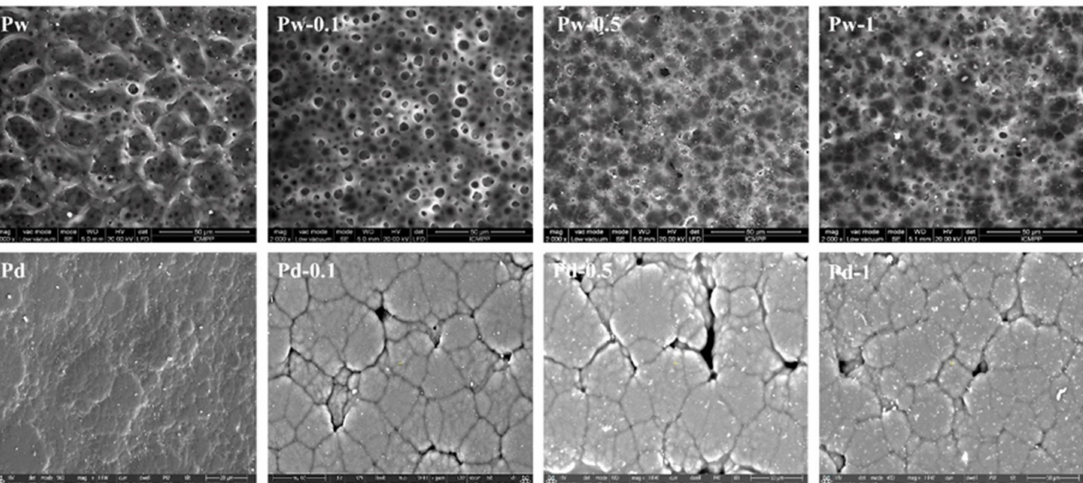
Figure 6. SEM analysis of membrane surfaces prepared by wet (Pw) and dry (Pd) solution casting methods and embedded with different concentrations of IONPs (0.1, 0.5, and 1